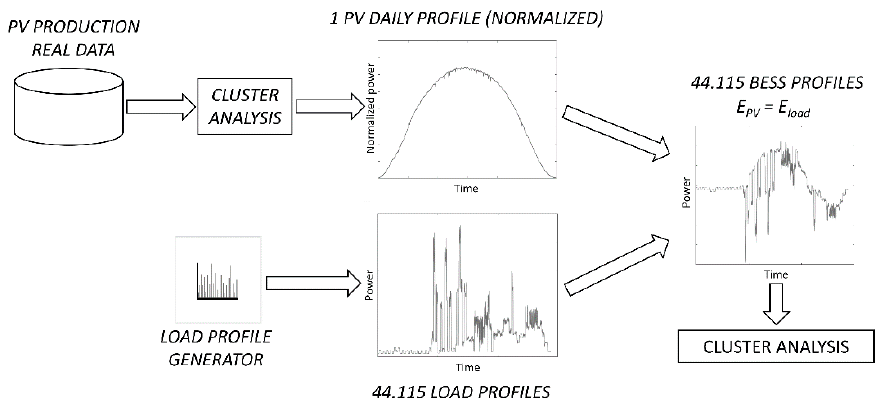
Figure 4. Battery profiles building flowchart of the procedure adopted.